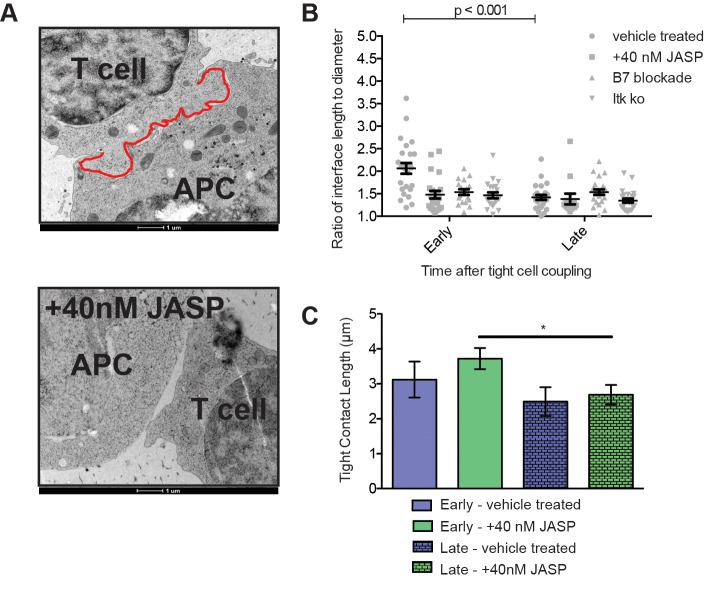
Low dose JASP treatment inhibits the formation of early T cell interface membrane undulations.(A) Representative electron micrographs of 5C.C7:CH27 conjugates at an early time point as control (top) and treated with 40nM Jasplakinolide (bottom) are given. In the control image the interface part of the T cell membrane is highlighted in red to illustrate the membrane undulations. The control image is from the same cell couples as Fig 3B in the accompanying manuscript. (B) 5C.C7 T cells were activated with peptide-loaded CH27 APCs (10μM MCC) and processed for EM at an early and late time point as detailed in the methods section. The interface length to diameter ratio is given for four conditions: control 5C.C7 T cells (number of cell couples analyzed across multiple independent experiments, n = 51), 5C.C7 T cells treated with 40nM Jasplakinolide (n = 35), Itk-deficient 5C.C7 T cells (n = 55), 5C.C7 T cells activated by CH27 APCs upon blockade of B7-1/2 (n = 41). (C) Lengths of tight interface contact between at the T cell:APC (i.e. regions of opposing T cell:APC membrane <20nm apart rather than the entire interface outline denoted as ‘interface length’) are given from some of the same electron micrographs analyzed for B. Error bars are s.e.m.. Significance was determined by Student’s t-test and is indicated by an asterisk (*p<0.05).